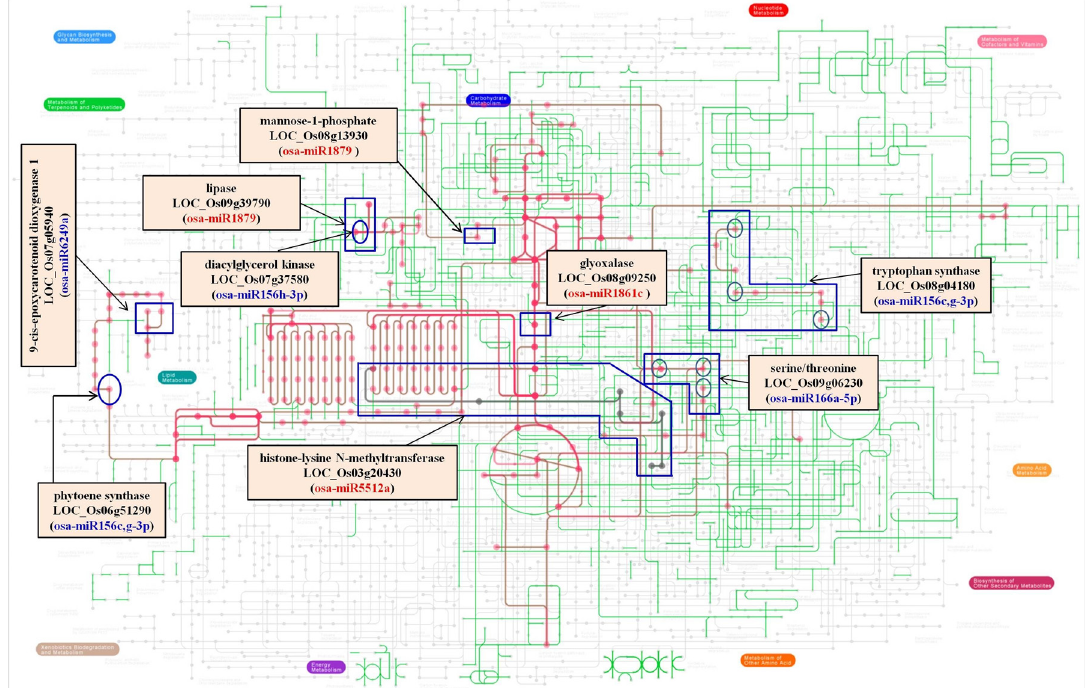
Figure 5. The metabolomics network employed to highlight the nodes regulated by miRs. Transcripts targeted by miRs have been marked. miRs up regulated in PKSR are indicated in blue. miRs down regulated in PKSR are indicated in red. PKSR: Pokkali root tissues grown in the presence of salt.